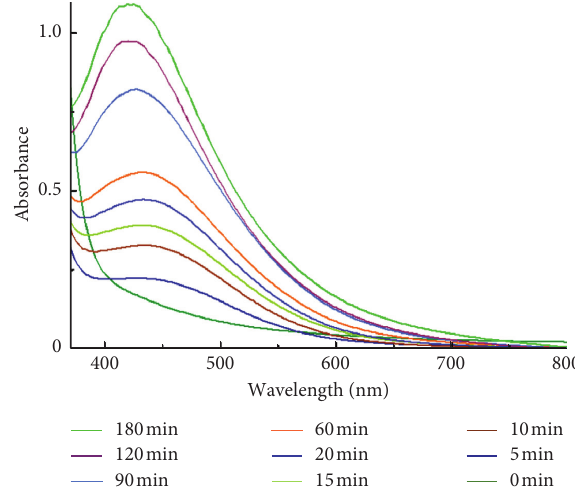
Figure 2: Time-dependent UV-vis spectra of AgNO